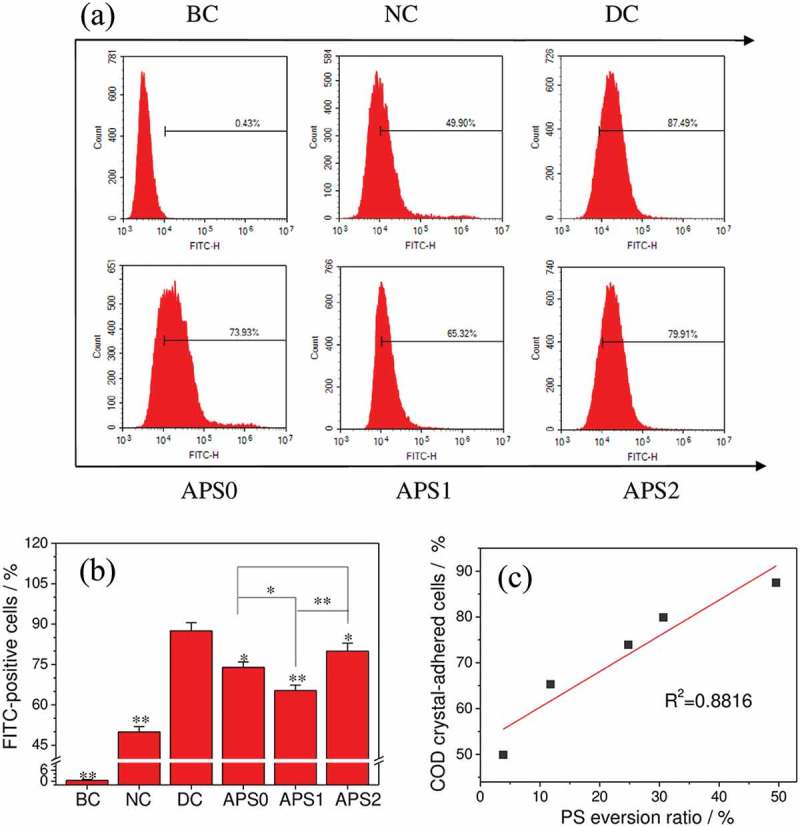
Quantitative detection of the proportion of adherent nano-COD crystals of HK-2 cells before and after APS with different molecular weights repair by flow cytometry. (a) Histogram of the proportion of cells with adhered COM crystals; (b) statistical histogram of the proportion of cells with adhered COM crystals; (c) the linear relationship of a percentage of cells adhering to nano-COD crystals and PS expression, R2 is a linear correlation coefficient. BC: blank control, NC: normal control, DC: damaged control; Polysaccharide concentration: 60 μg/mL; oxalate damage concentration: 2.6 mmol/L; damage time: 3.5 h; repair time: 10 h. Compared with DC group, *P < 0.05; **P < 0.01.